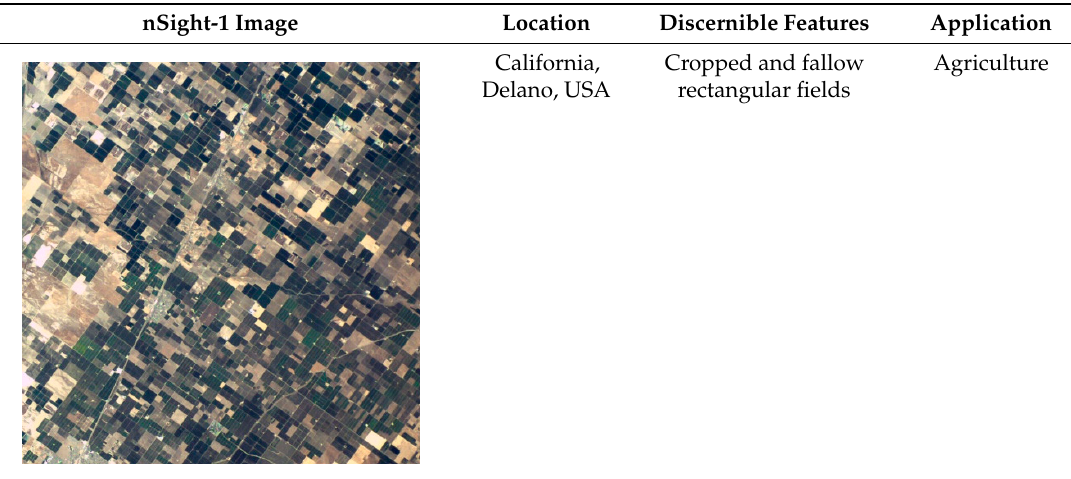
Table 5. Interpretation of nSight-1 images and some potential applications